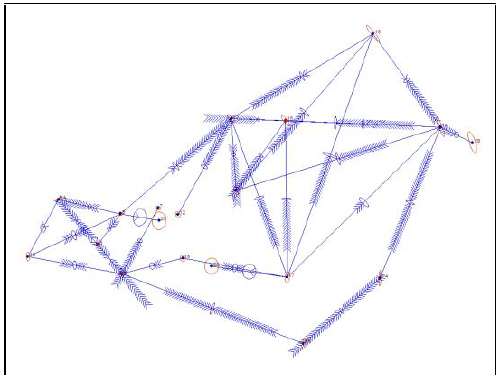
Figure 3. Star*Net Least Squares Adjustment